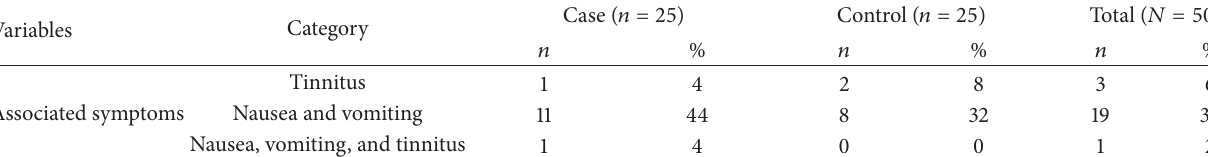
Table 3: Associated symptoms.